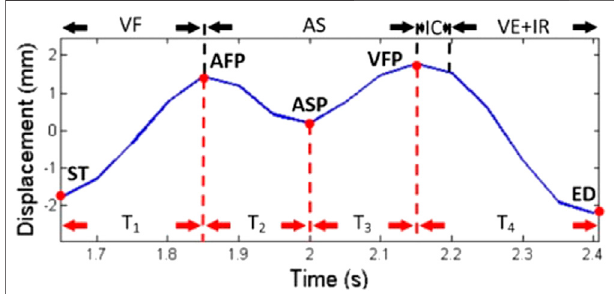
FIGURE7| Cardiacmotionmarker.Thecardiacmotioncyclede fi nedby fi ve different markers (red dots) at fi ve different points of displacement and timing was calculated as a unique feature for recognizing people. From Lin et al.